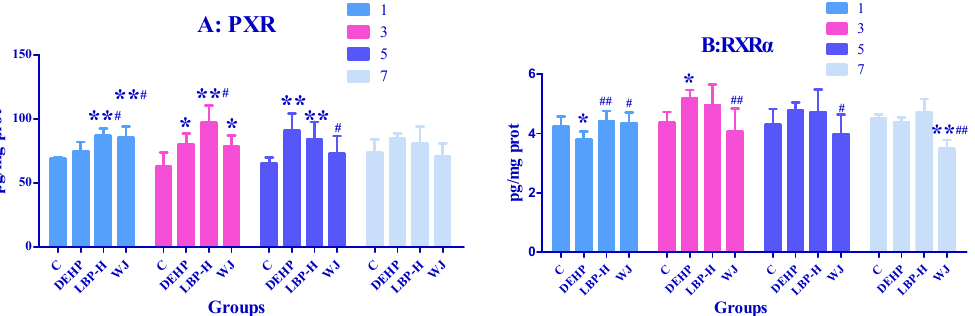
Figure 7. Effects of LBP and WJ intervention on transcriptional regulator activity in rats exposed to DEHP ( n = 5). After one day of DEHP feeding, LBP and WJ were used for continuous intervention, and the transcriptional regulator activity (PXR and PXR α ) was measured by ELISA kit on the first, third, fifth, and seventh day of intervention. This is the concentration of PXR( A ) and PXR α ( B ), respectively. Note: data are expressed by mean ± S.D. The significance of differences among treatment groups was determined by one-way ANOVA. * or **: compared with control group, p < 0.05 or 0.01; # or ## : compared with DEHP group, p < 0.05 or 0.01.